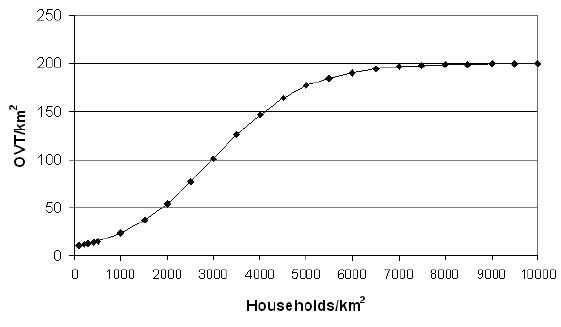
Fig. 1 – Logistic function describing the number of cells to be sam- pled according to the household